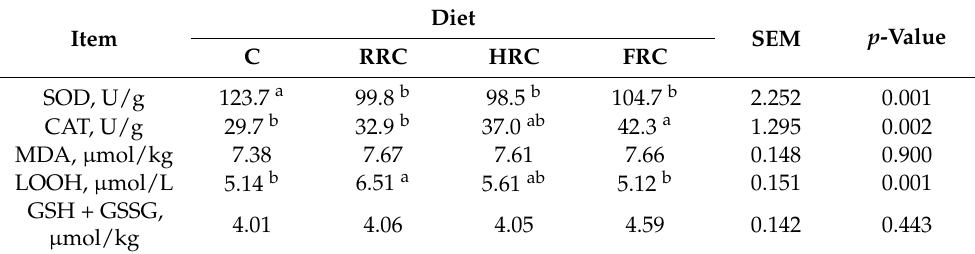
1 Data representing mean values of 10 eggs per treatment. a,b Means within the same column with different superscripts differ significantly ( p < 0.05); SOD, superoxide dismutase; CAT, catalase; MDA, malondialdehyde; LOOH, lipid peroxides; GSH + GSSG, total glutathione.